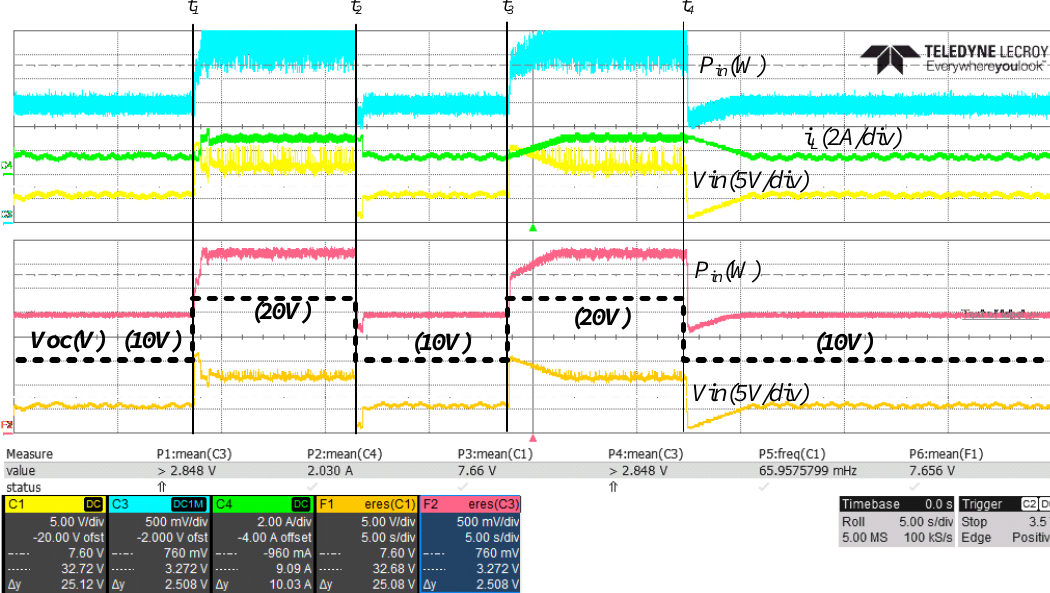
Figure 12. Experimental comparison waveforms for the current, voltage, and input power under the conventional perturb and observe (P&O) and the proposed MPPT algorithms. (Lower part is filtered version of the upper part).